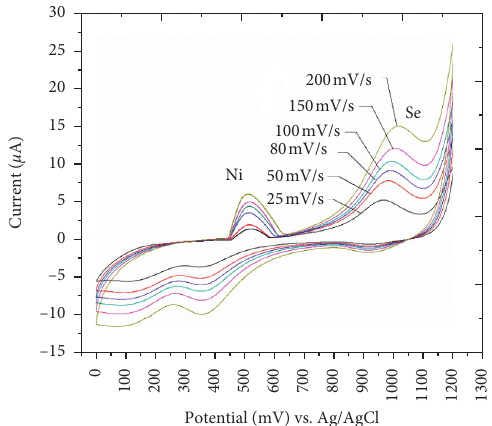
Figure 5: Cyclic voltammogram of Se (IV) and Ni (II) at a con- centration of 250 µ g/L with a variation of scan rate in 0.1M PBS and 5 mM Fe(CN) 6 using Mn 3 O 4 -Cn electrode at 25 ° C in the range of − 10 to